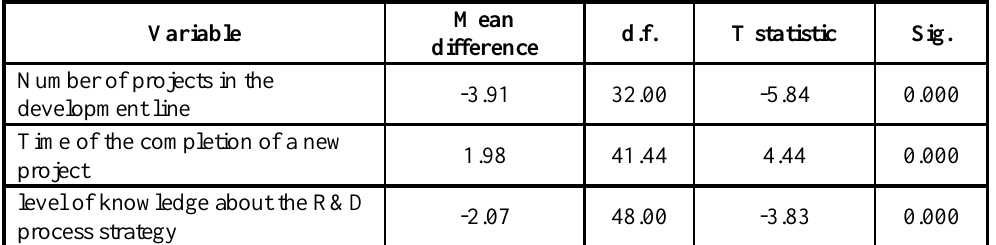
Table 13. independent t-test to examine the effect of complementary causal links Variable development line